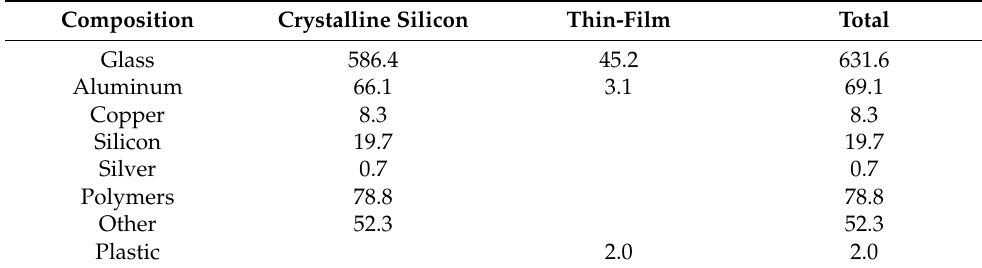
Table 2. Compositions of raw materials (in 1000 tons) in solar PV power plants that should be decommissioned from 2044 to 2059. Composition Crystalline Silicon Thin-Film Total Glass 586.4 45.2 631.6 Aluminum 66.1 3.1 69.1 Copper 8.3 8.3 Silicon 19.7 19.7 Silver 0.7 0.7 Polymers 78.8 78.8 Other 52.3 52.3 Plastic 2.0